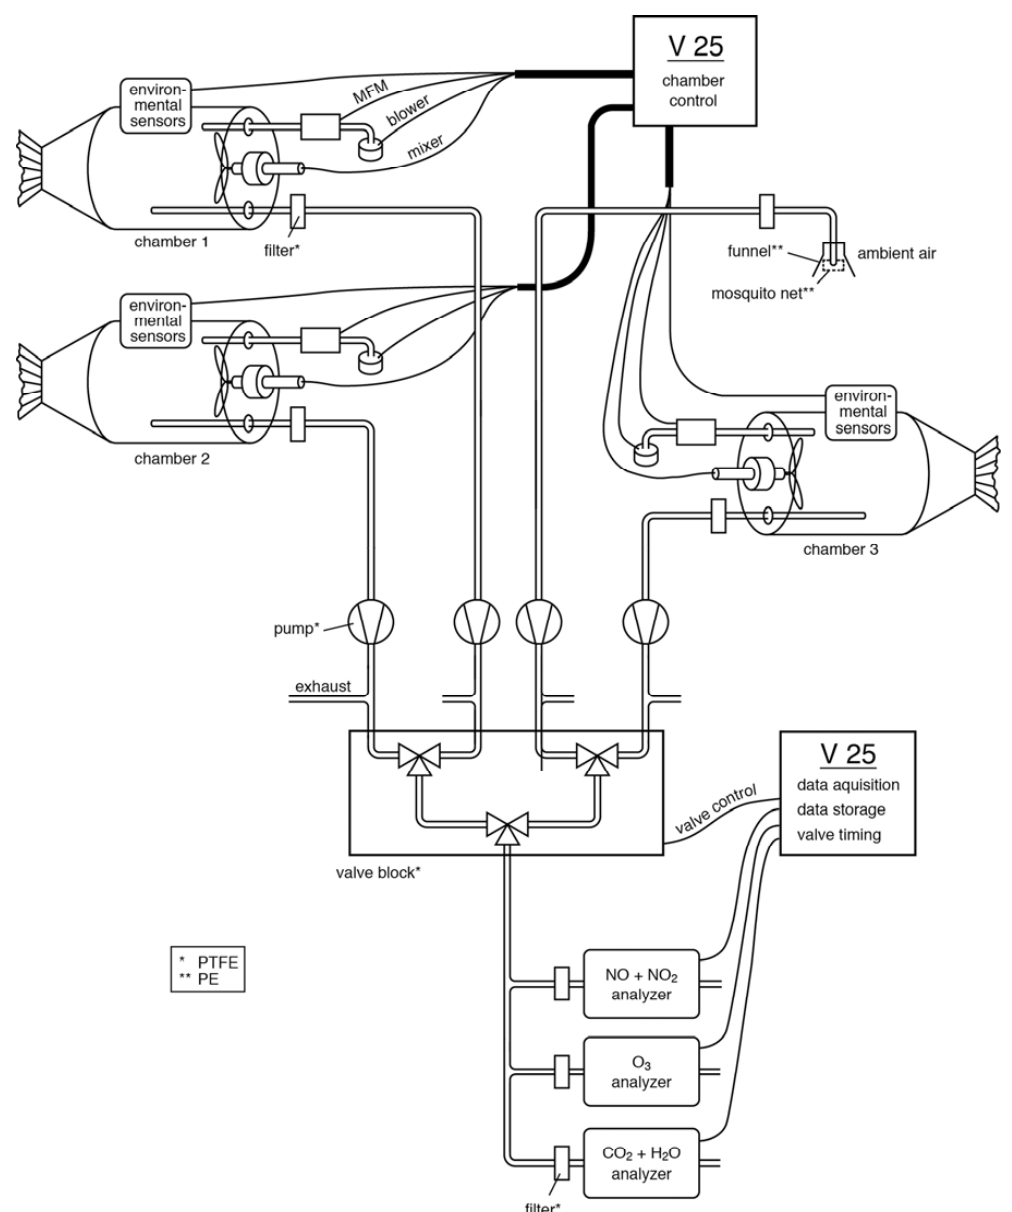
Fig. 5. Schematic set-up of the system with three dynamic chambers. Open lines are PFA sampling tubes, black lines are cables for data acquisition and control. 4